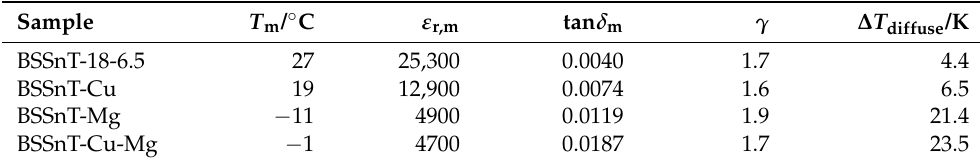
diffuse ) of BSSnT-